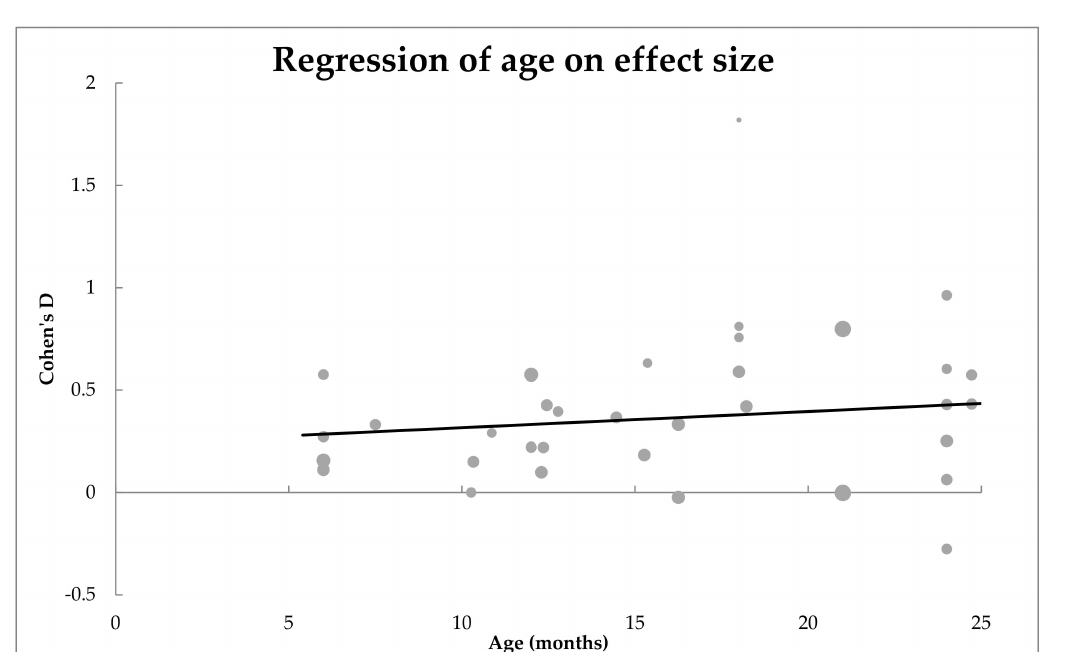
Figure 2. Scatterplot of how age moderated the mean difference between EL and TL infants’ expres- sive vocabulary. No significant effect of moderator was observed.